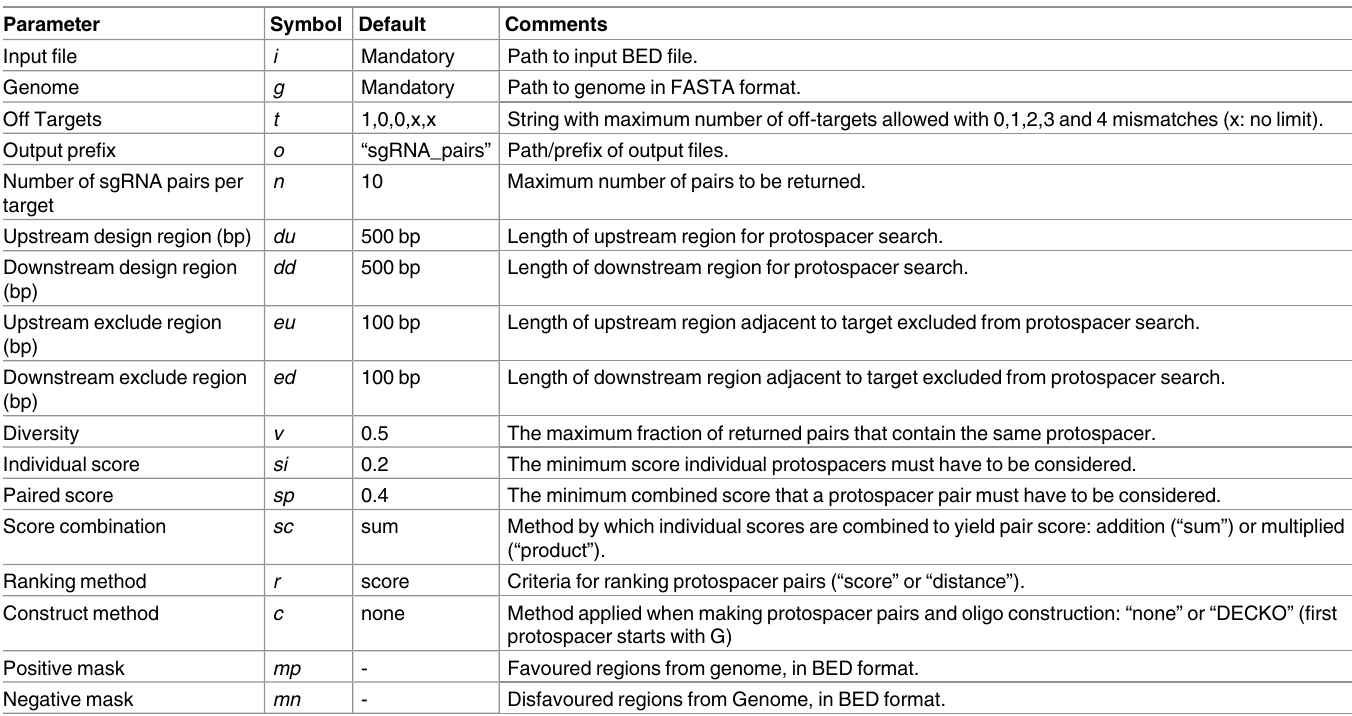
Table 1. User-definedparameters.